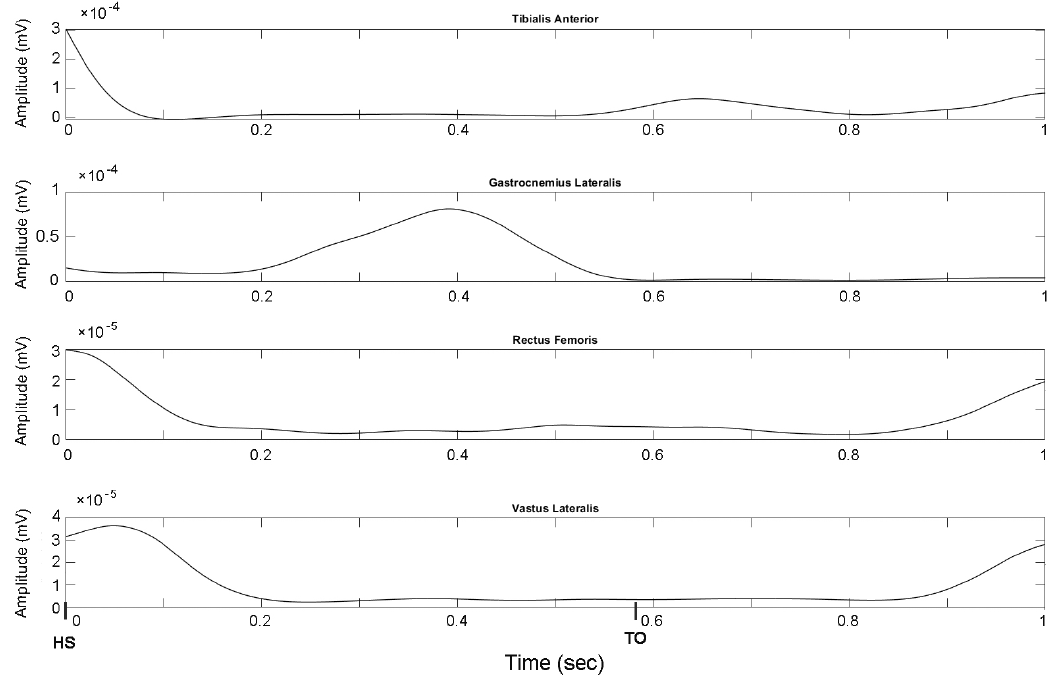
Figure 3. The envelope resulting from the pre-processing of the raw EMG signals recorded from the four muscles of the right leg. Corresponding HS and TO timing are